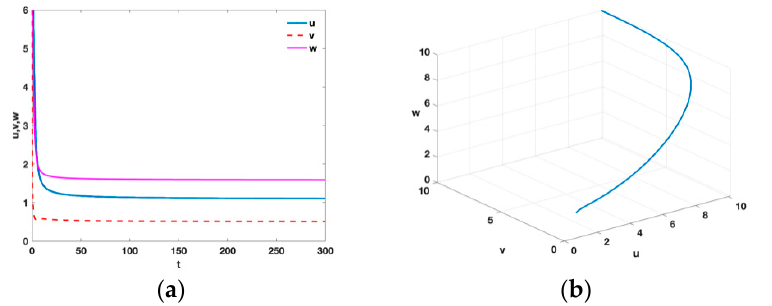
Figure 7. Time series ( a ) and phase diagram ( b ) of equilibrium point ˆ A = ( 1.11,0.51,1.64 ) with